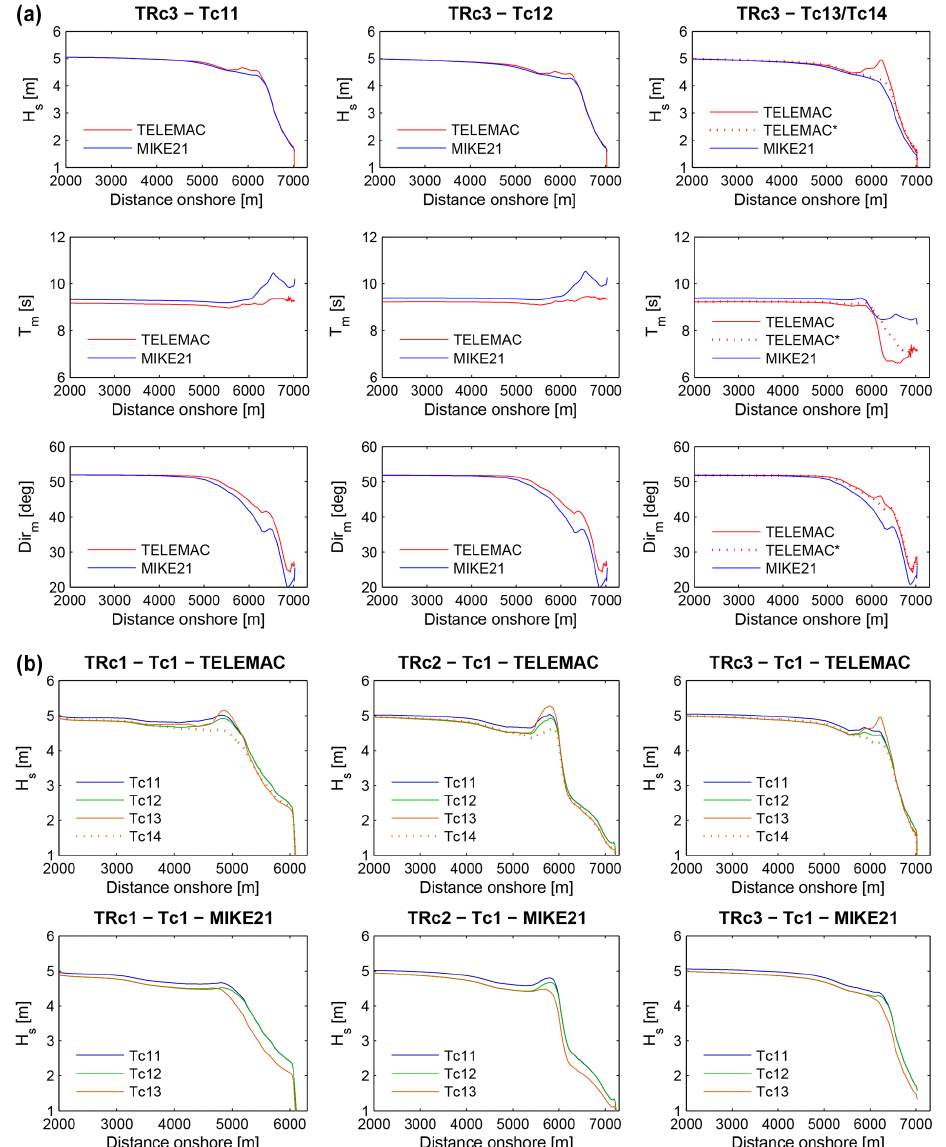
Figure 6. (a) Comparison of TELEMAC and MIKE21 results ( H s − T m − Dir m ) along transect TRc3 for the Brindisi–Torre Guaceto case study (forcing WE1; ∗ = Tc14); (b) effect of different processes on H s for TELEMAC (top) and MIKE21